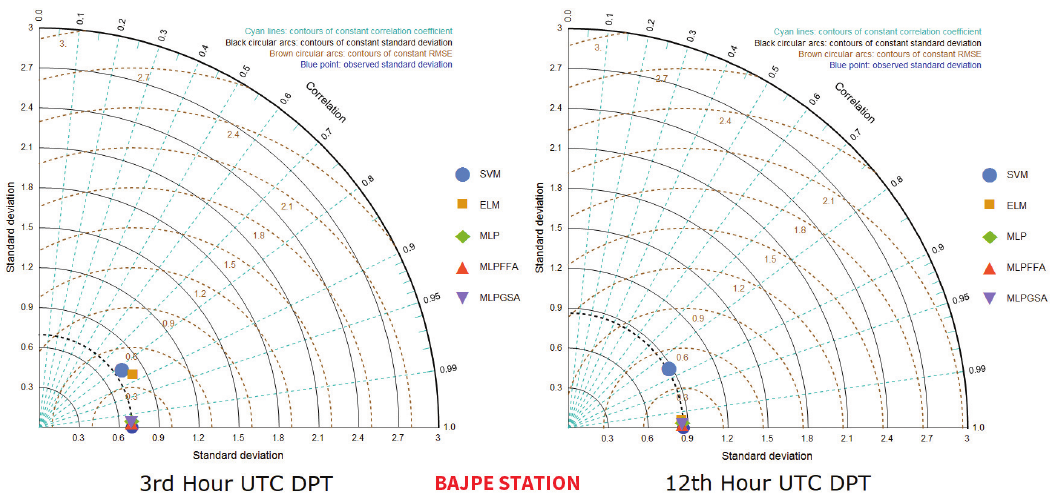
Figure 4. Taylor diagram for performance evaluation of the models with respect to Bajpe